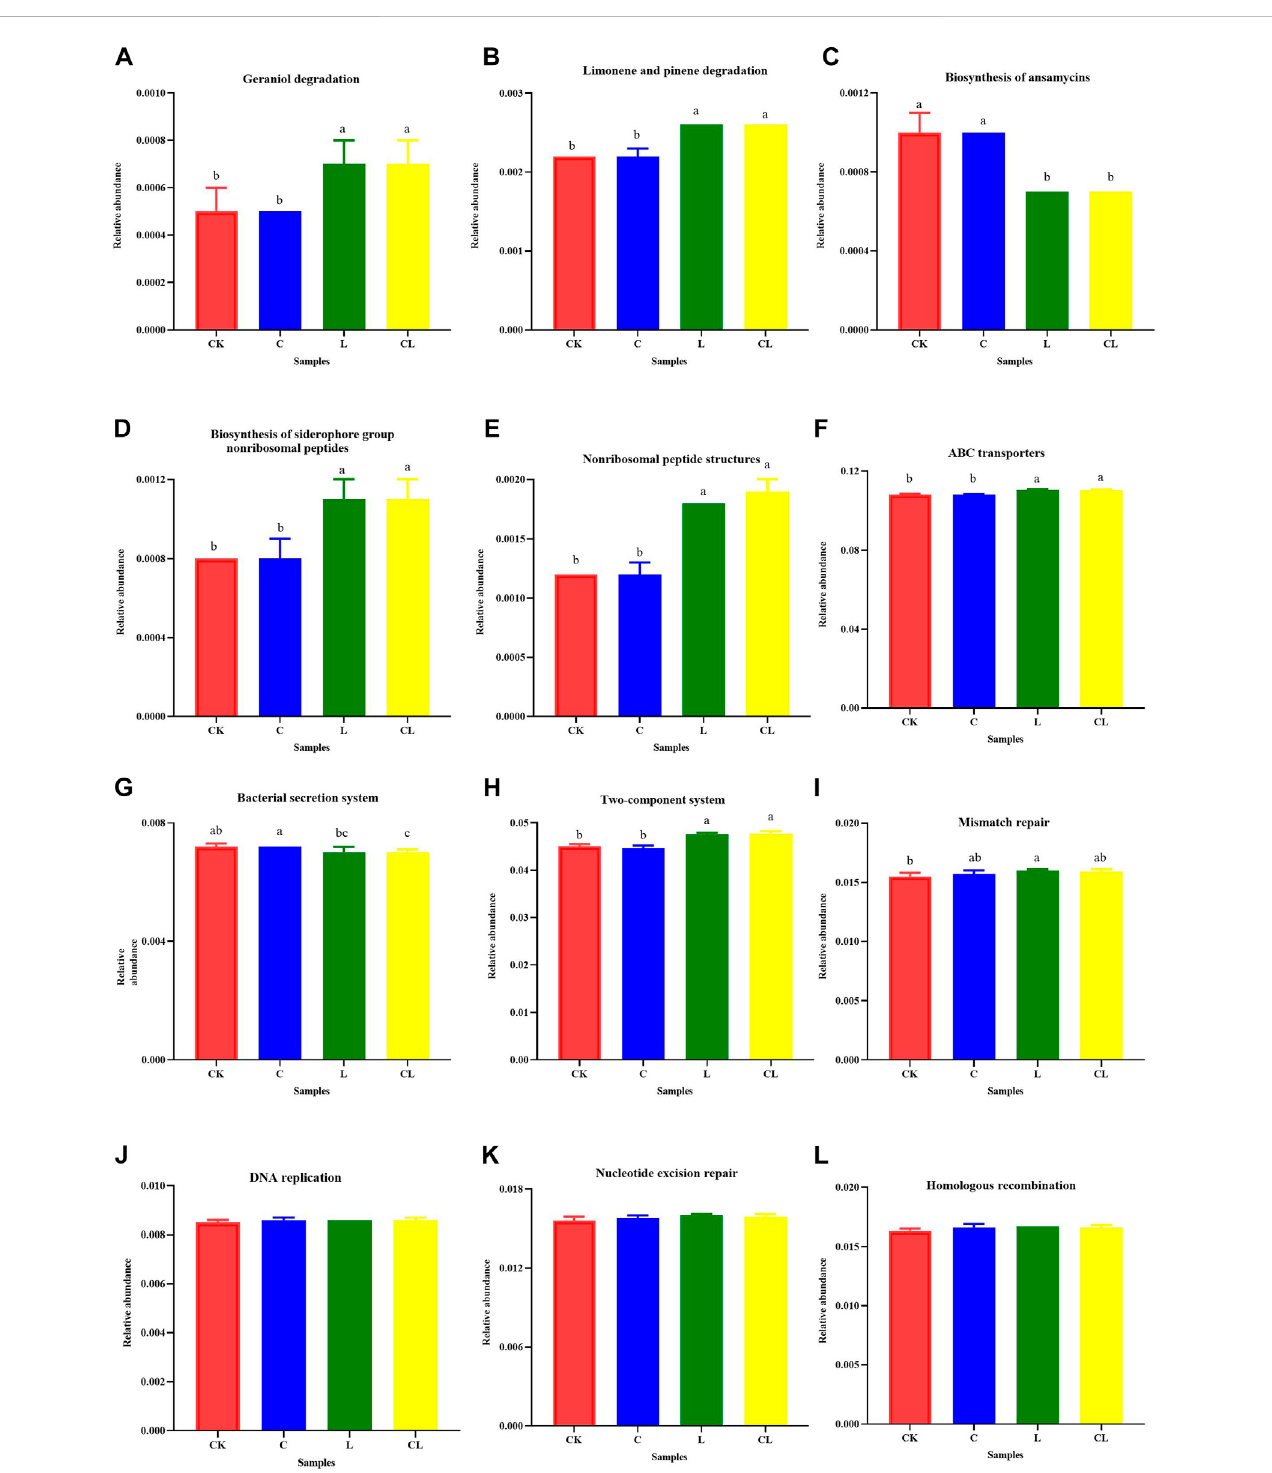
FIGURE 6 Effects of some Kyoto encyclopedia of genes and genomes metabolic pathways obtained with Tax4Fun in different groups on the metabolism of terpenoids and polyketides (A – E) , membrane transport (F, G) , signal transduction (H) , and replication and repair (I – L) . Different letters in the same column indicate signi fi cant differences ( p < 0.05). CK, no additive; C, cellulase; L, Lactiplantibacillus plantarum ( L. plantarum ); and CL, cellulase + L. plantarum